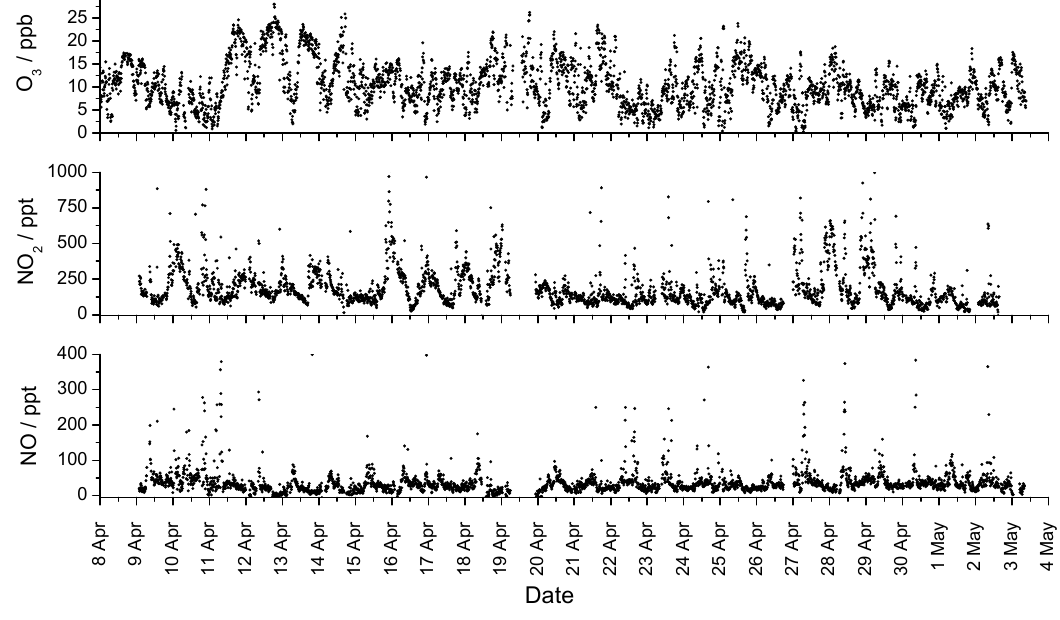
Fig. 1. Time series of measured NO , NO 2 , and O 3 at the Bukit Atur GAW ground site, plotted versus local time (GMT+8).